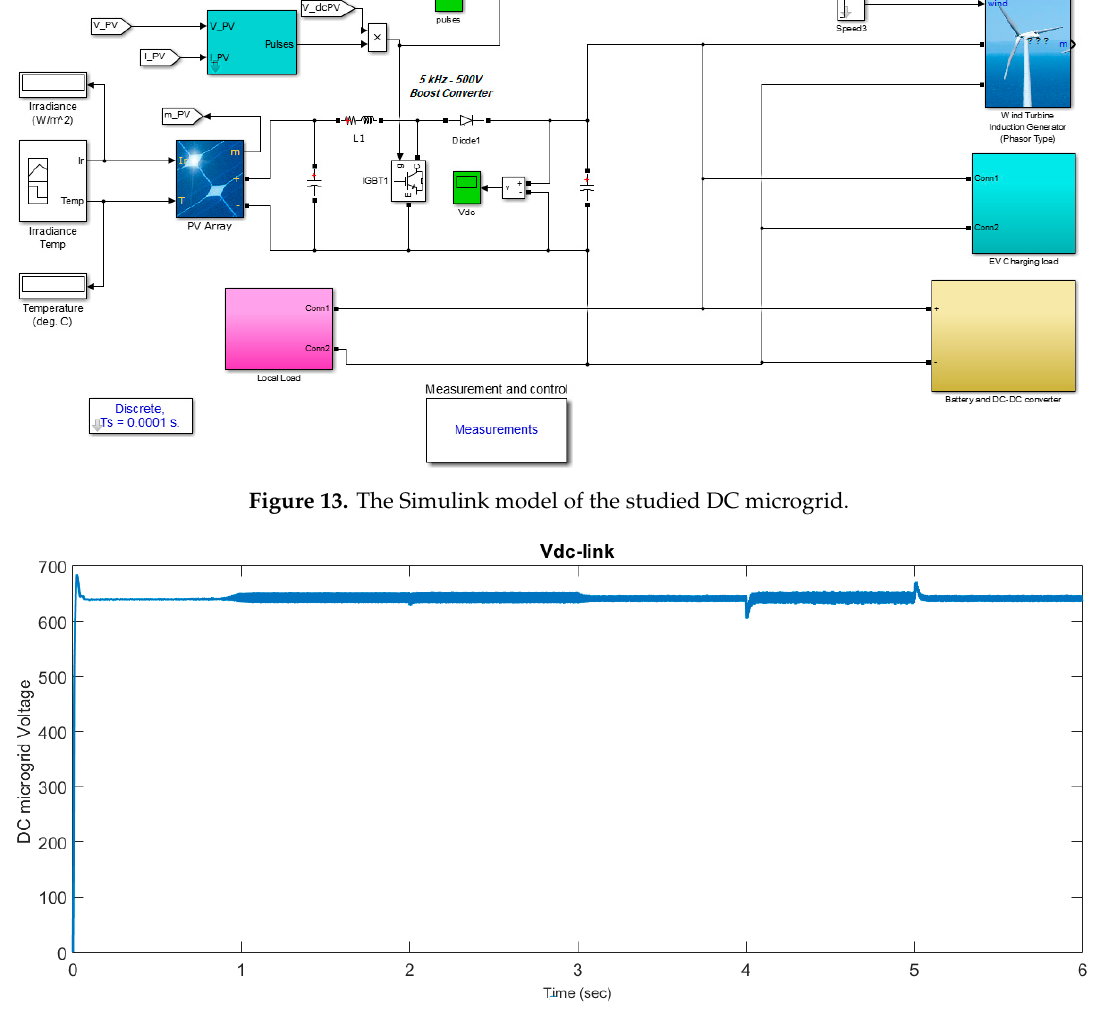
Figure 14. DC-microgrid DC-link voltage.